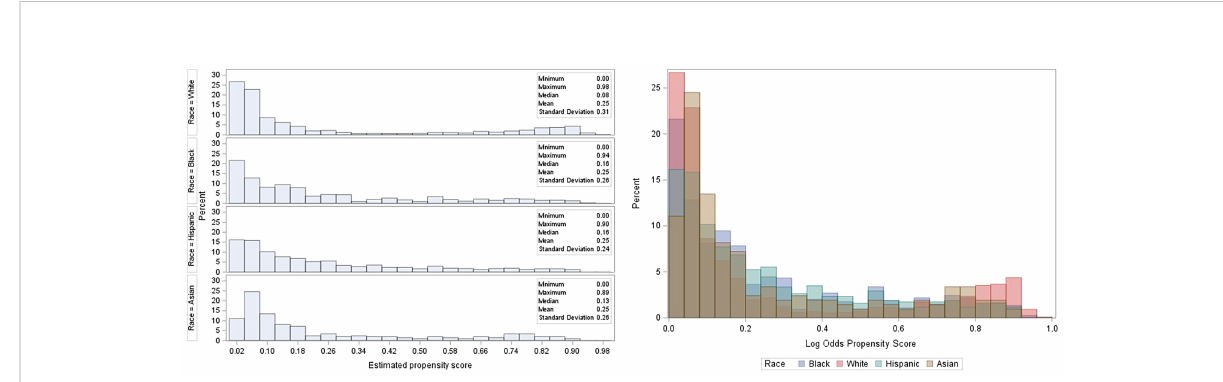
FIGURE 4 Histogram showing the distribution of propensity scores by treatment (racial) group. From L to R: stacked histogram showing individual propensity scores for treatment groups, the overlap of propensity scores among treatment groups.